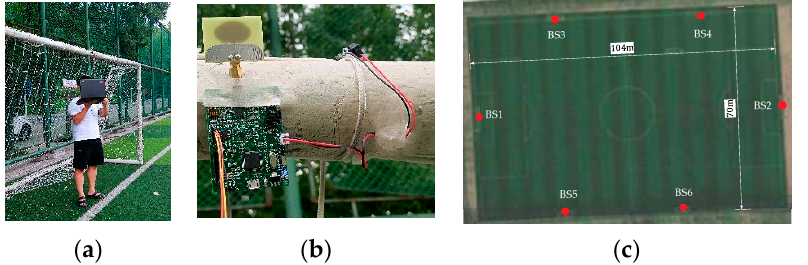
Figure 9. The environment of base station deployment (( a ) receive the location information of the base station through the computer; ( b ) place the base station on the upper goal frame; ( c ) base station layout under satellite cloud image).